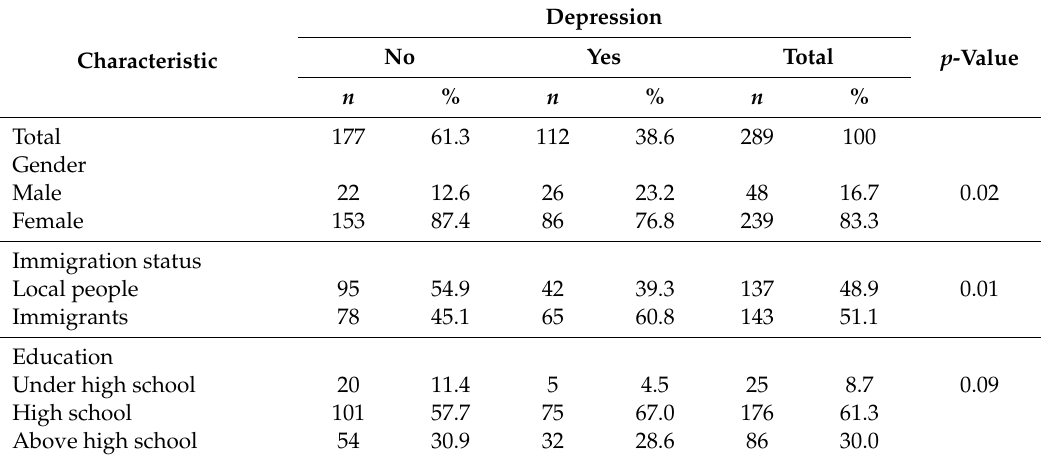
Table 1. Socio-economic characteristic of